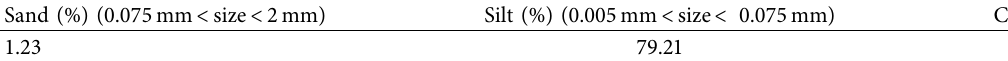
Table 1: Particle contents of the studied loess.